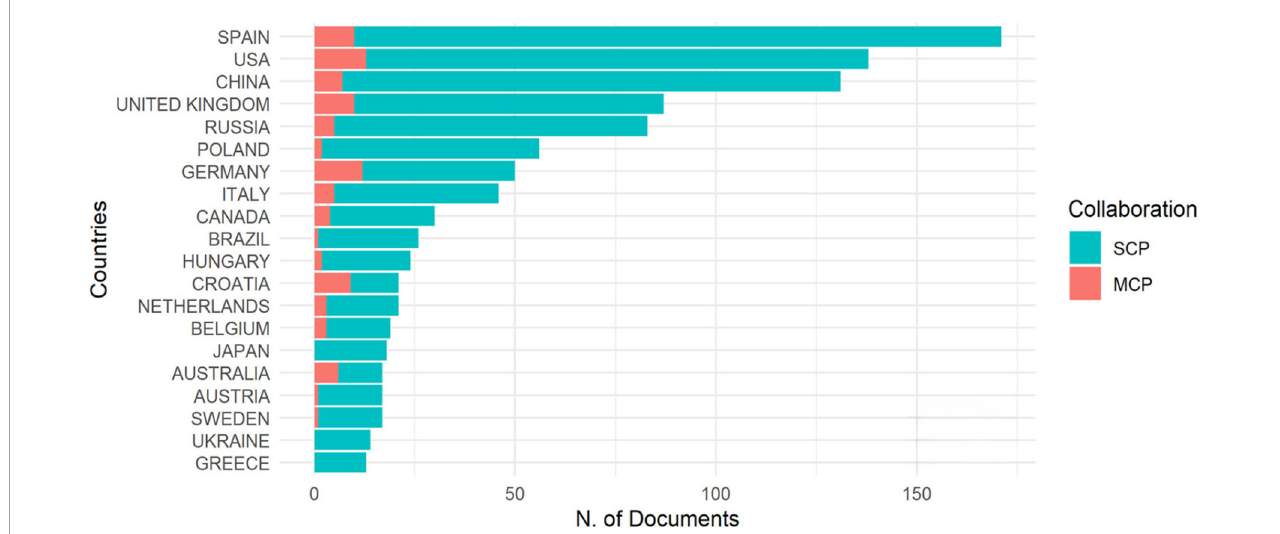
FIGURE5 Corresponding author’s country. Multiple country publications (MCP), the number of papers co-authored with authors from other countries; SCP, the number of papers co-authored by authors of the same nationality. The MCP ratio represents the ratio of international cooperation.